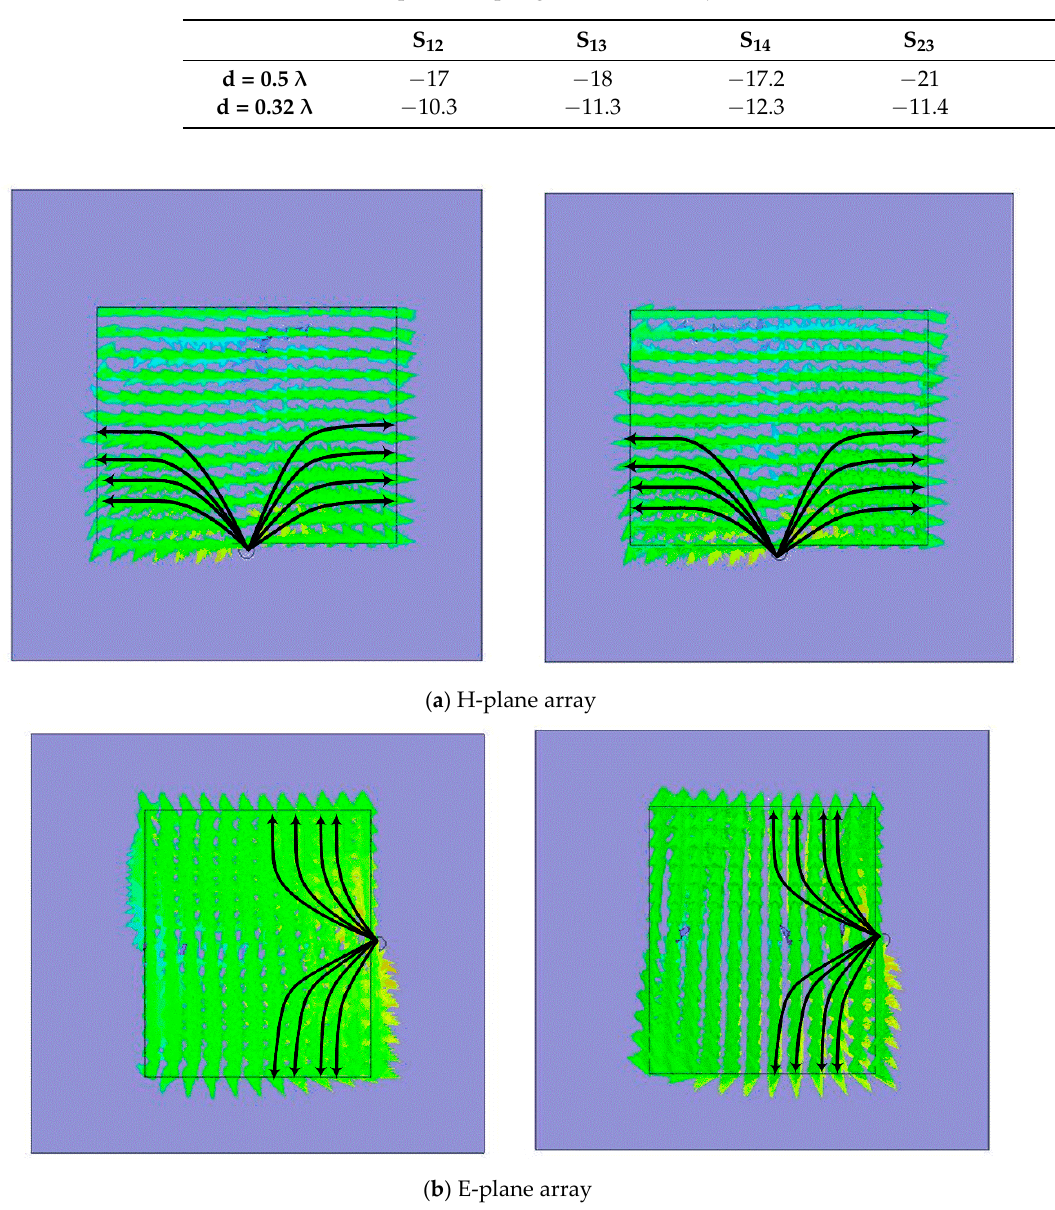
Table 2. Measured H-plane coupling coefficients (|Sij|) dB.